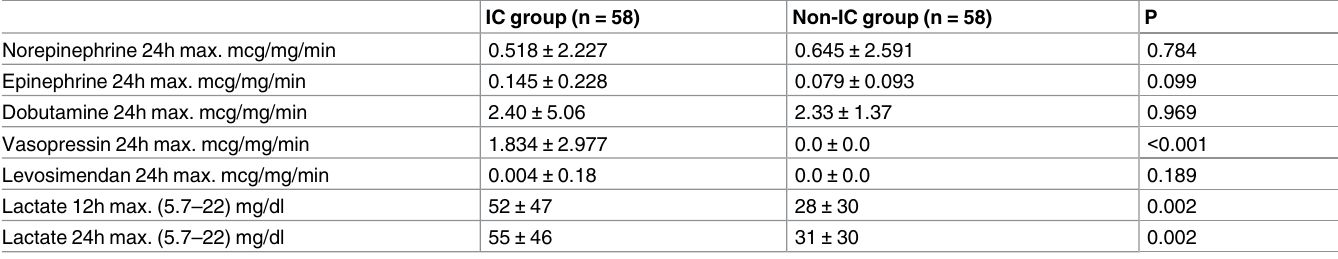
Table 4. Postoperative catecholamine therapy and lactate